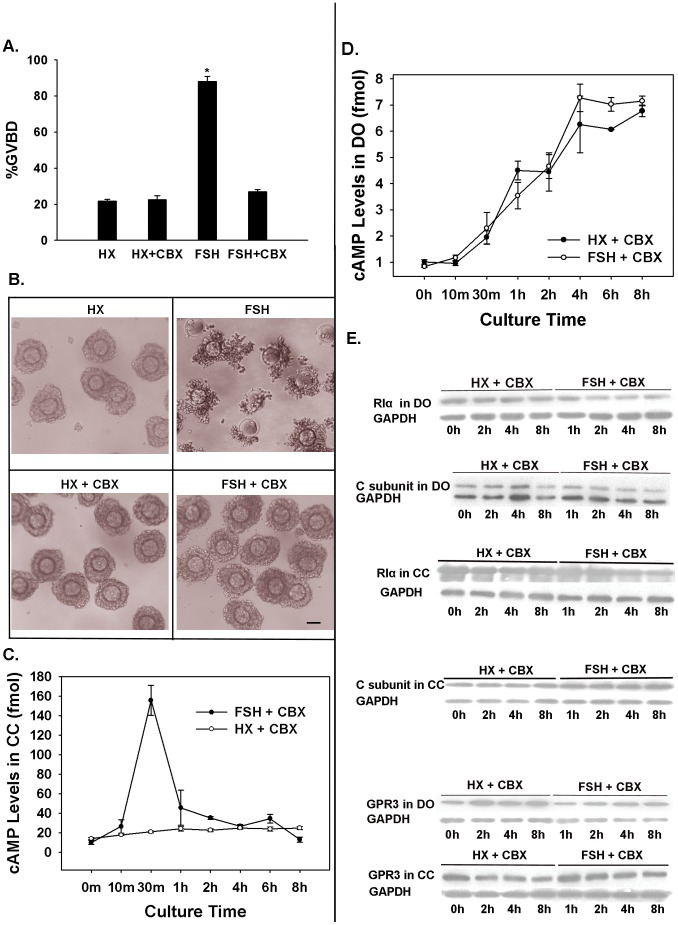
The effects of GJC on PKAI, GPR3 levels and cAMP surge in oocytes of COCs stimulated by FSH.(A) Carbenoxolone (CBX) completely suppressed FSH-induced GVBD. COCs were preincubated for 0.5 h in HX medium containing 100 µM CBX. Then FSH was added to some COC cultures, and the cultures were maintained for 22 h. Percent GVBD was then determined. The bar marked with the asterisk is significantly different from the other bars. (B) CBX suppressed FSH-induced cumulus expansion of COC. HX, control; FSH, 50 IU/L FSH; HX+CBX, HX medium supplemented with 100 µM CBX; FSH+CBX, HX medium supplemented with 50 IU/L FSH and 100 µM CBX. Scale bar, approximately 50 µm. (C) cAMP levels in cumulus cells (CCs) of COCs preincubated with CBX and then treated with FSH. (D) cAMP levels in oocytes of COCs preincubated with CBX and then treated with FSH. A mean of 100 COCs were used at each time point in each of three replicate experiments. The mean ± SEM of three individual experiments are shown. (E) Inhibition of oocyte-cumulus cell GJC abolished FSH-induced changes in PKAI and GPR3 levels. COCs were preincubated for 0.5 h in HX medium containing 100 µM CBX. Then FSH was added to the culture medium. DOs and CCs from 200 COCs treated/not treated with FSH were collected at various time points and analyzed by Western blotting. The blot shown is representative of three experiments.